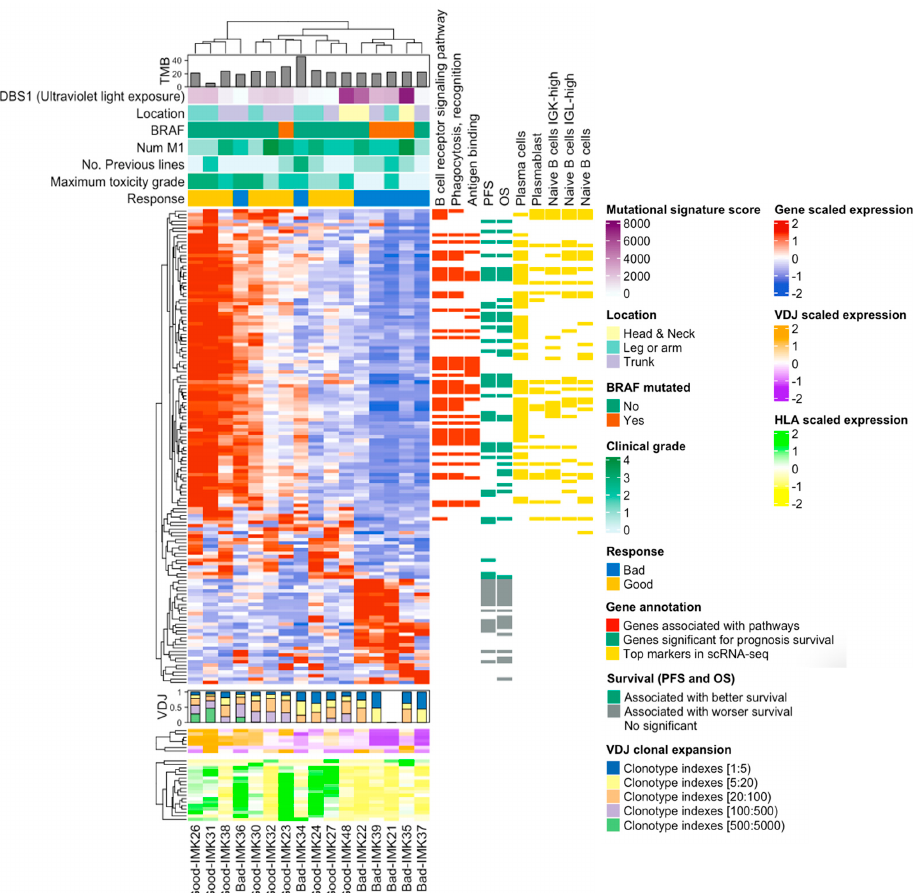
Figure 7. Onco-heatmap: integration of bulk RNA-seq data, the VDJ and HLA abundance and genes features. In the upper part of the ComplexHeatmap, we represent the clinical and genomic information. The DE expressed genes in good versus bad responders are located in the center of the plot. The diversity and abundance analysis of VDJ are plotted just below the DE analysis, using a bar plot and heatmap as graphs, respectively. HLA expression is presented at the bottom of the graph. Finally, details about the differentially expressed genes can be found on the right-hand side. We depict GO information, relationship with survival and gene validation in single-cell RNA-seq cohort. 2.12. Machine-Learning-Based Models Based on Our Transcriptomics Gene Signature Predict Response in Eight External Melanoma Cohorts Treated with ICB Predictive gene signatures have been developed based on the variable importance of the Random Forest (RF) model. In our cohort, the predictive power of the gene signature was characterized by an AUC of 0.98, and the subset of selected genes were DOK6 , AC084082.1 , IGKV1-27 , IGLV3-1 , CLEC4E , FRRS1L , IGHV6-1 , IGKV3D-11 , IGLV6-57 ,